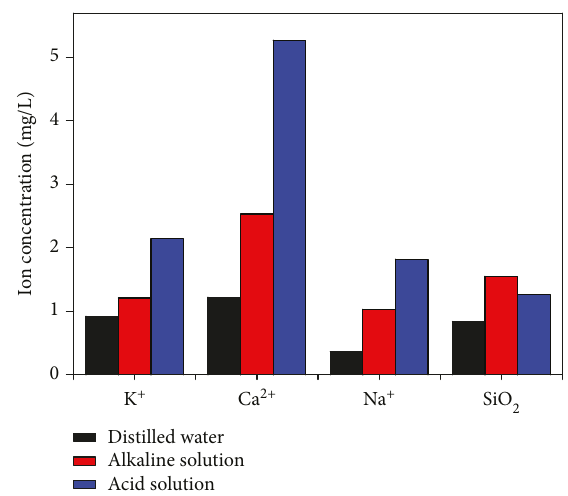
Figure 14: Ion concentrations of chemical solutions after